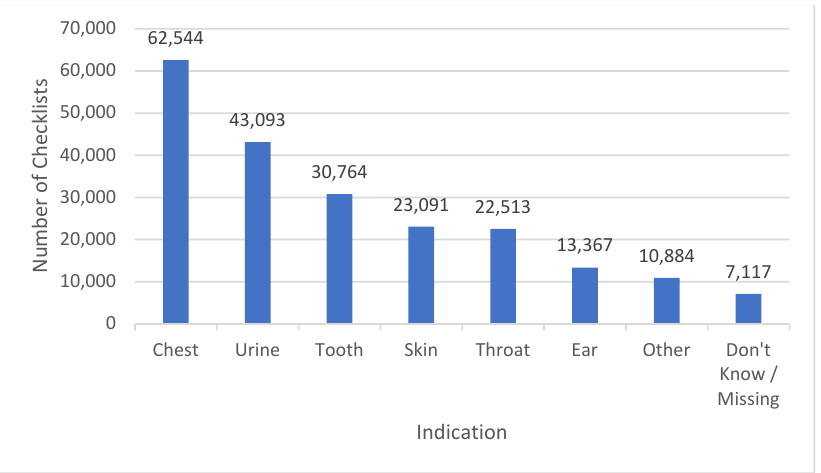
Figure 1. The frequency of infection type reported by patients collecting antibiotic prescriptions.